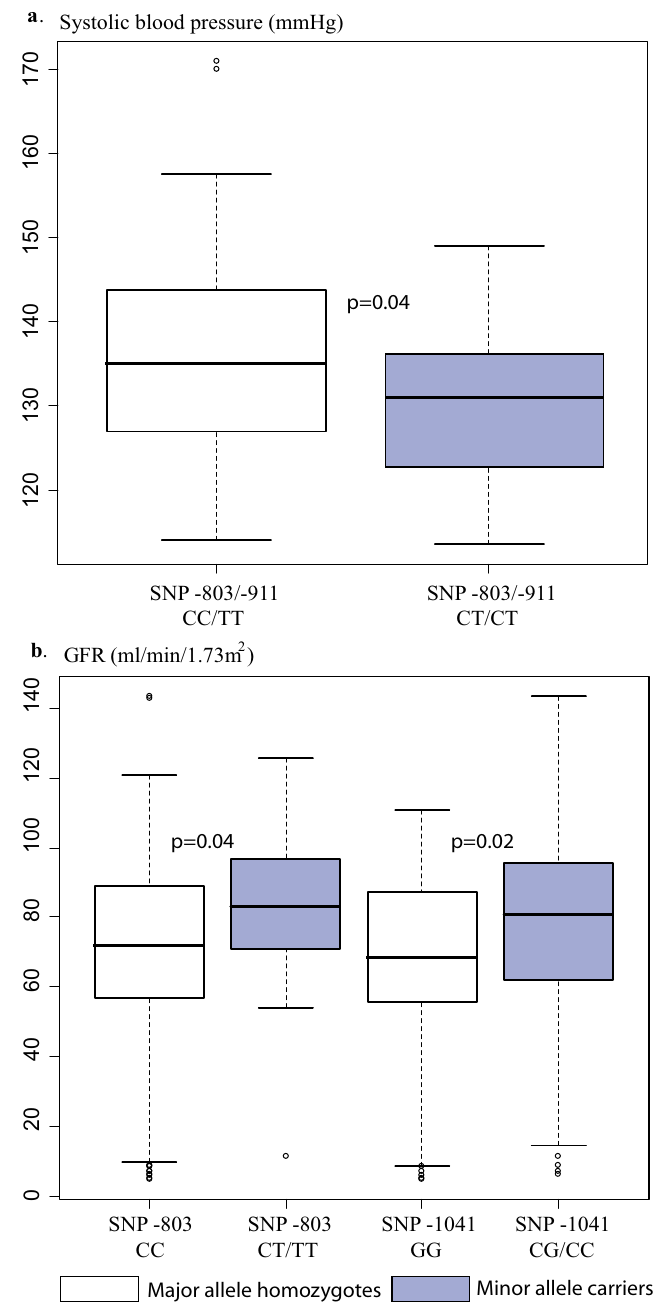
Figure 4 Notched box plots for the distribution of (a) systolic blood pressure (SBP) readings; and (b) estimated glomer- ular filtration rate (GFR) values for the major allele homozygotes and the minor allele carriers of NAT8 pro- moter SNPs. The boxes represent the 25 th and 75 th percentiles. The median is denoted as the line that bisects the boxes. The whiskers are lines extending from each end of the box covering the extent of the data on 1.5 × interquartile range. Circles rep- resent the outlier values. P-values from Mann-Whitney U-test are shown, applied to test the statistical difference in the distri- butions of SBP or GFR estimates between two